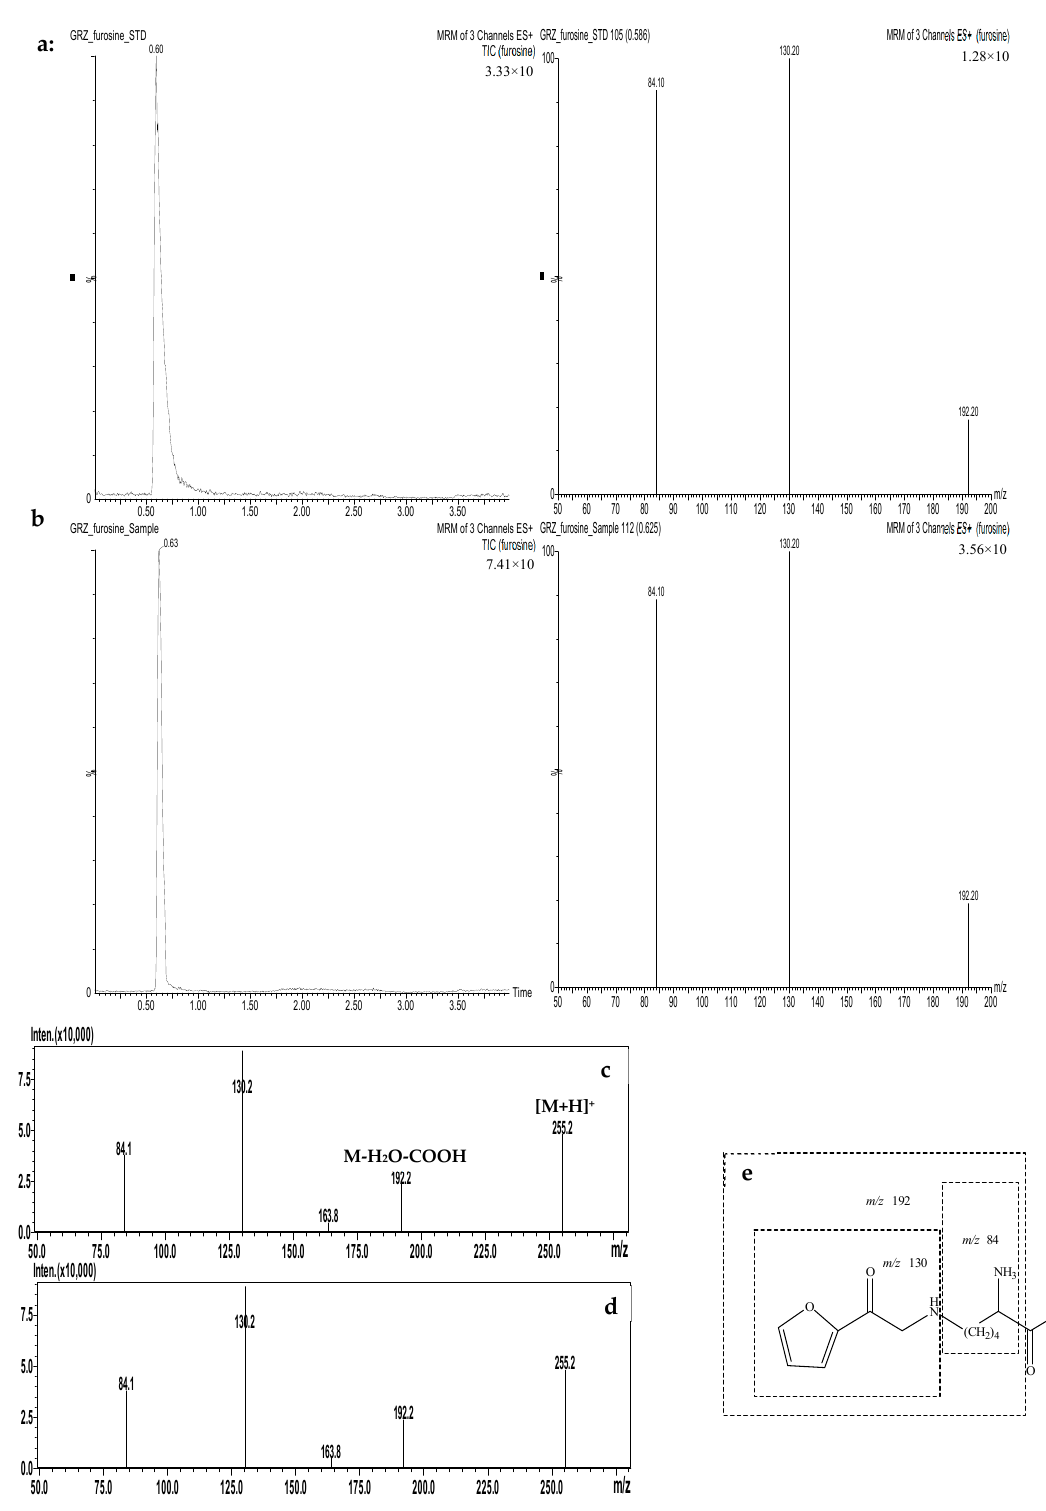
Figure 2. Total ion chromatograms and selected ion intensities for the furosine standard ( a ) and a sample of powder slices of boiled velvet antler ( b ). Mass spectrum fragmentation pattern of the furosine standard ( c ) and a sample of powder slices of boiled velvet antler ( d ). Assignment of the fragmentation pattern of the furosine standard ( e